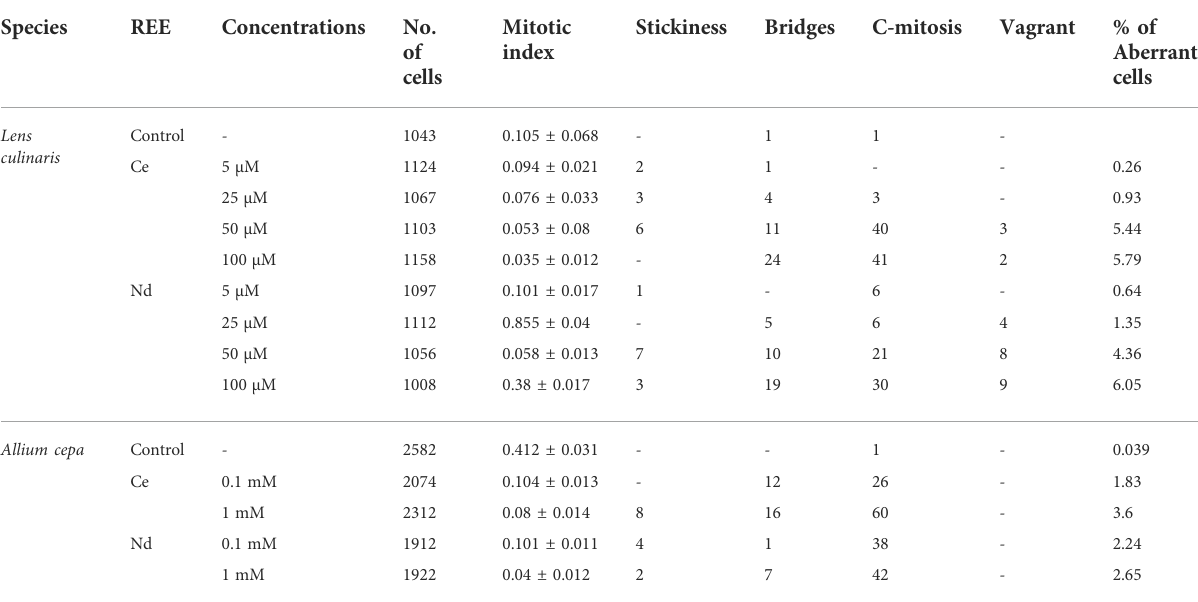
TABLE3CytogeneticanalysisofonionandlentilroottipsexposedtodifferentconcentrationsofREE;totalcellnumber,mitoticindexandpercentage of aberrations after 72 h of treatment with Ce and Nd, and control. The values represent the mean of three experiments ±SD. Treatments Chromosome